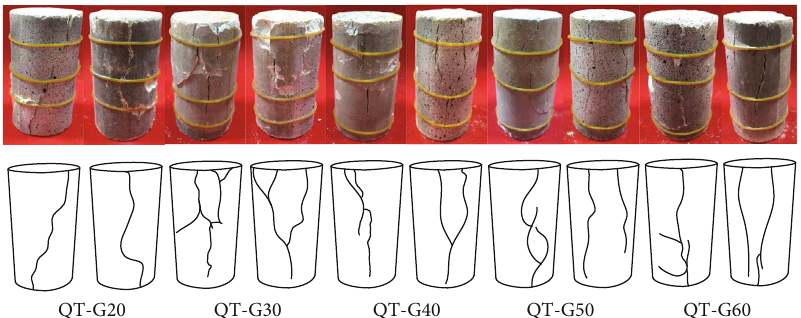
Figure 14: Failure characteristics of weakly cemented rock samples with di ff erent clay minerals.